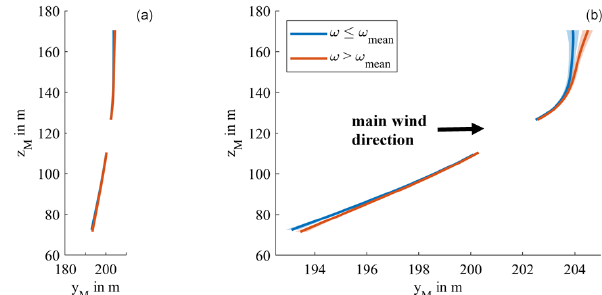
Figure 13. Blade deformation for different wind loads for blade 1: fourth-degree polynomial fitted through all measurement points on the blades for higher wind load ( ω > ω mean ) in orange and lower wind loads ( ω ≤ ω mean ) in blue, respectively, with (a) equal spacing between the y M and z M axis and (b) distorted